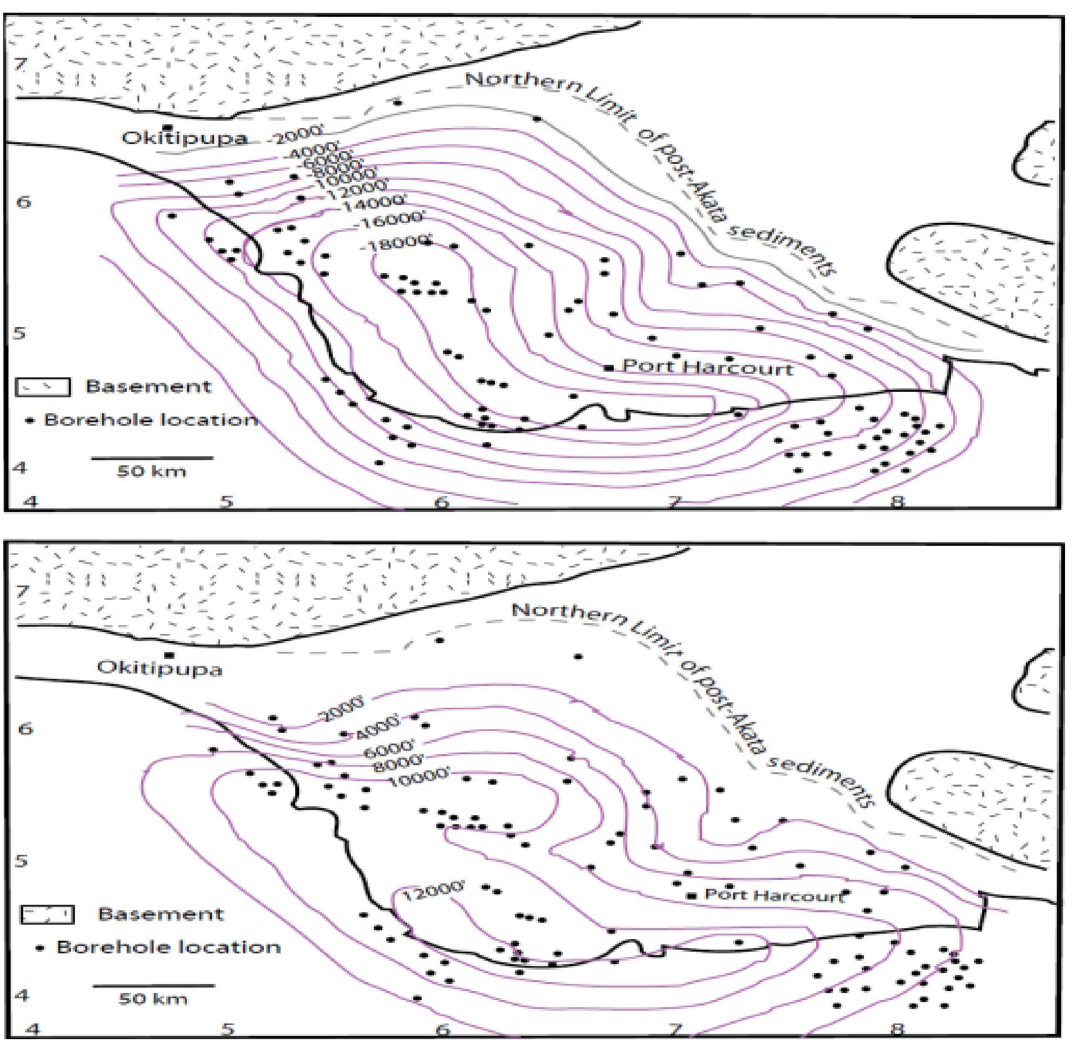
Fig. 7 Structural map of the top of Akata formation ( a ) and thickness isopach contours of the Agbada formation ( b ). Contours in 2000 foot inter- vals (Avbovbo 1978)